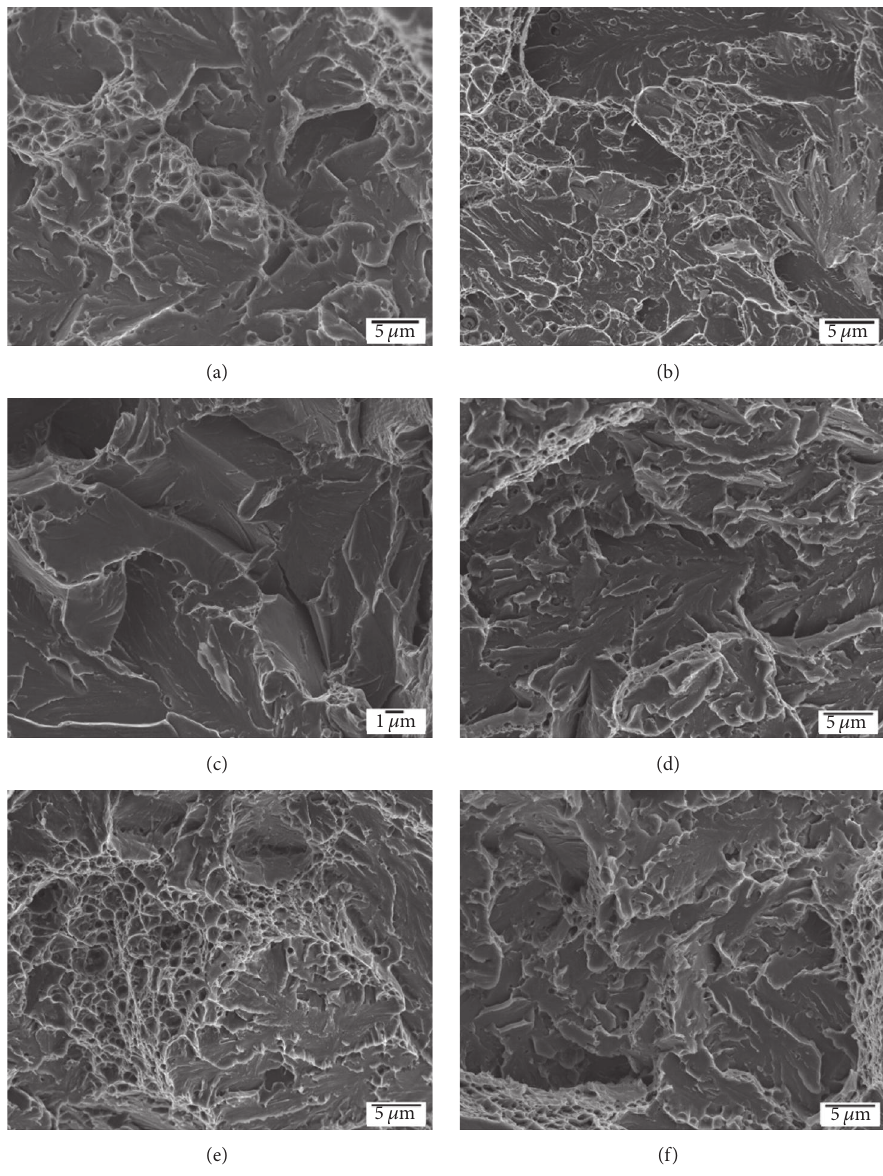
Figure 9: Fracture surfaces of CVN samples after impact toughness tests performed for individual weld regions, material states, and testing conditions:BM,PWHT,andRT(a);WM,PWHT,andRT(b);BM,625 ∘ C/30kh,andRT(c);WM,625 ∘ C/30kh,andRT(d);WM,625 ∘ C/30kh, and 100 ∘ C (e); HAZ, 625 ∘ C/30kh, and 100 ∘ C (f).